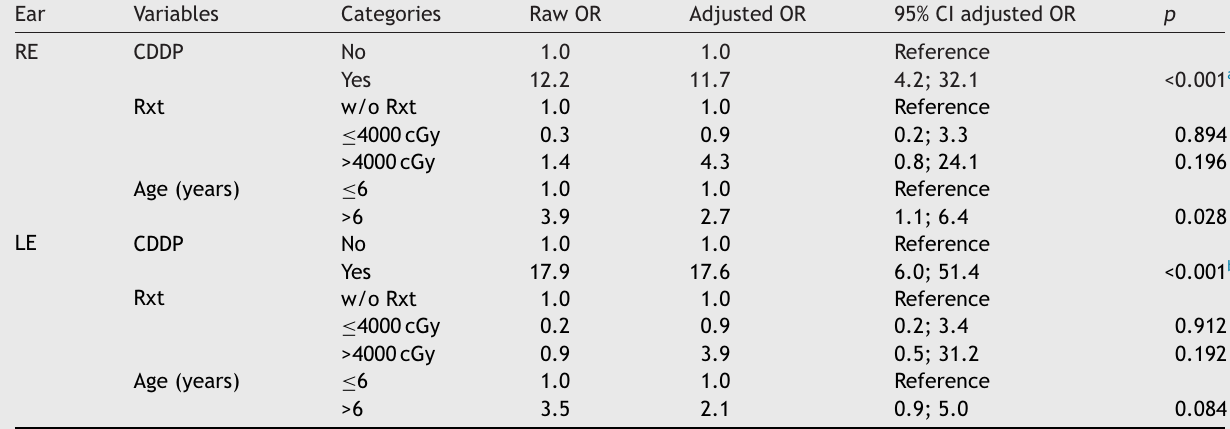
Table 4 Multiple analysis of predictive factors of hearing loss in the right (RE) and left (LE) ear. Ear